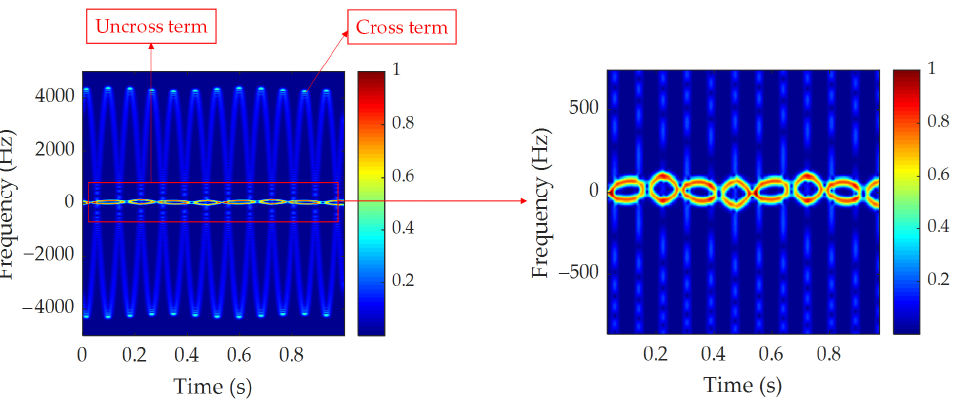
Figure 2. The STFT image of the echo signals after conjugate multiplication when there are multiple scatterers.